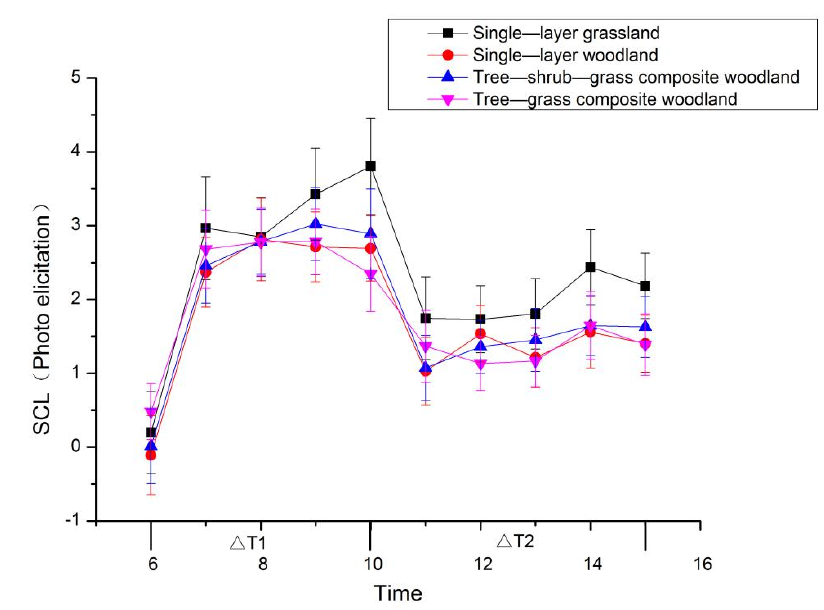
Figure 6. Effect of photo elicitation on the SCL indicators of the participants .